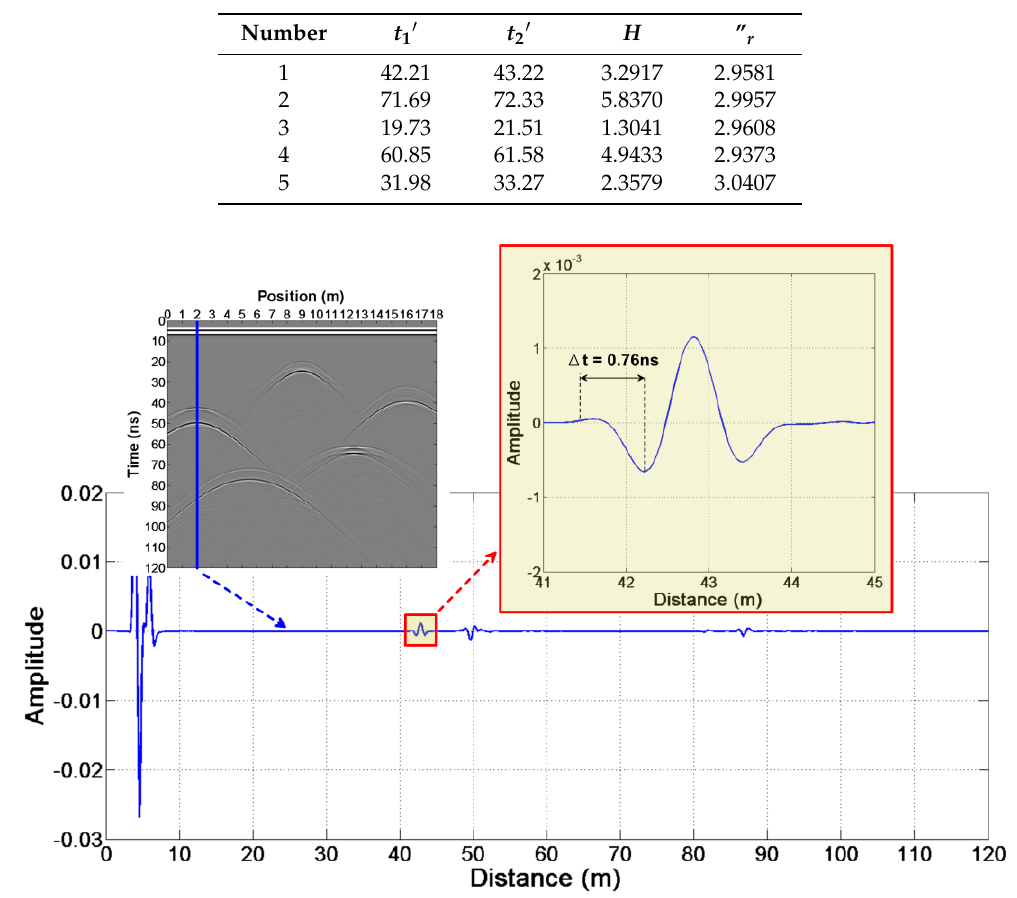
Figure 8. The reflection wavelet waveform of the abnormal body in the simple test model. Table 3. Estimated parameters of the simple experiment model.